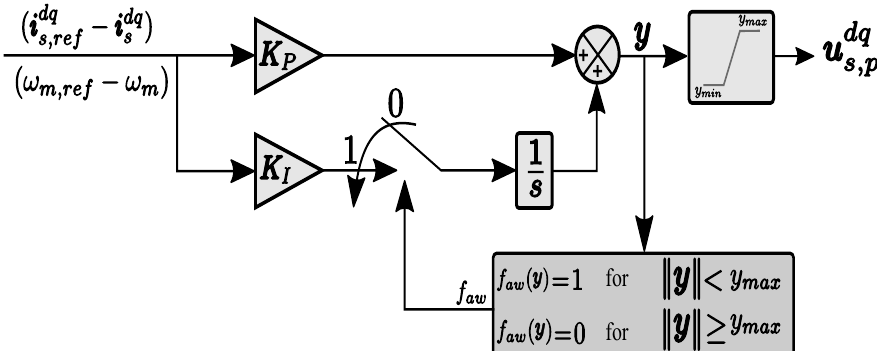
Figure 4. PI controller with anti-windup block diagram